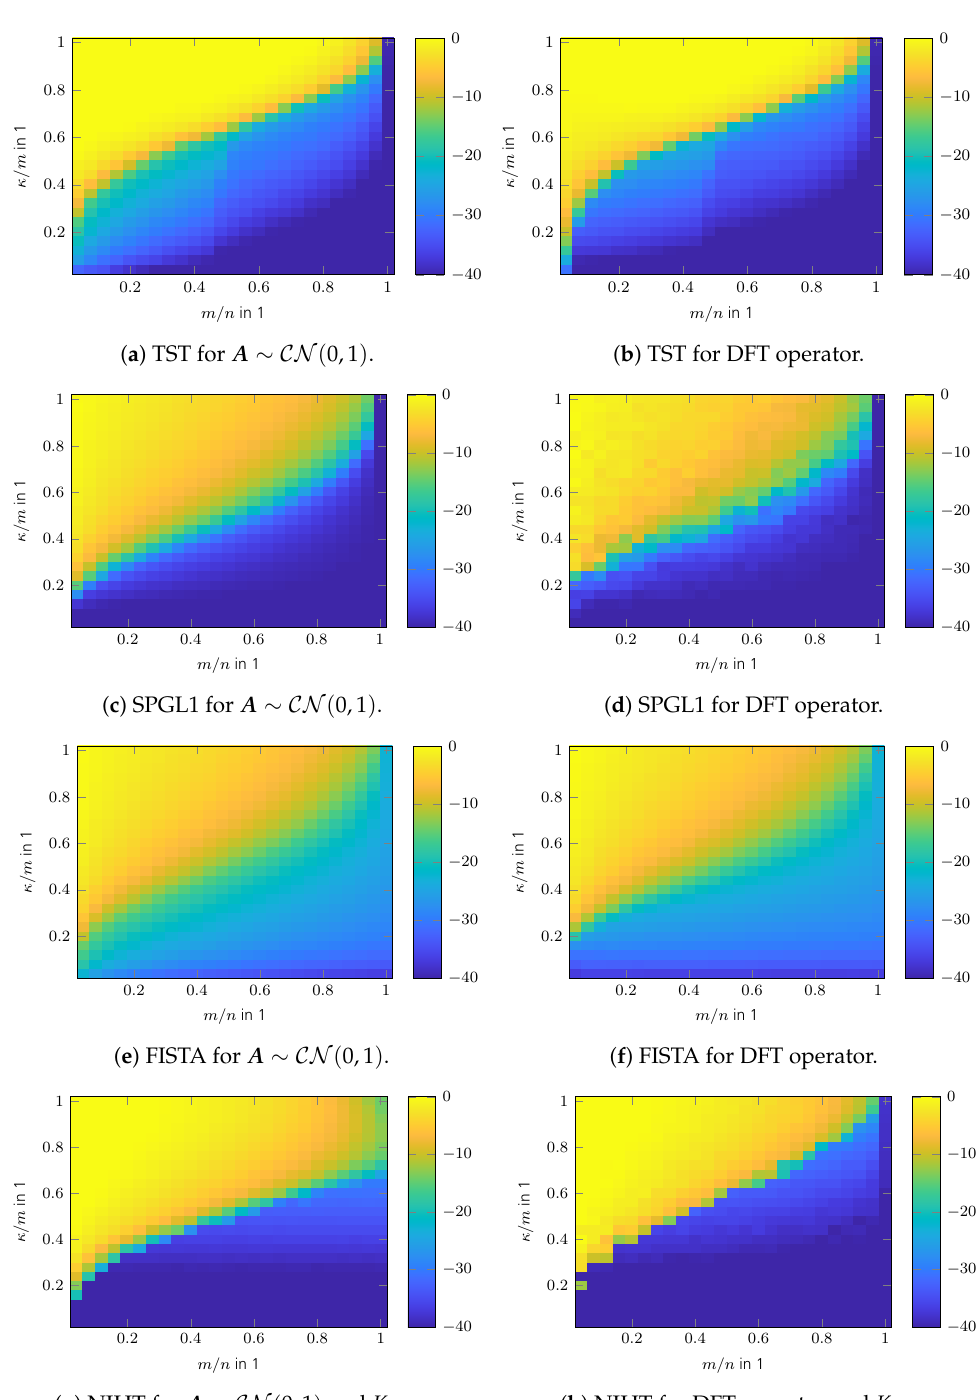
Figure 1. Phase transition of CS algorithms in SRE in